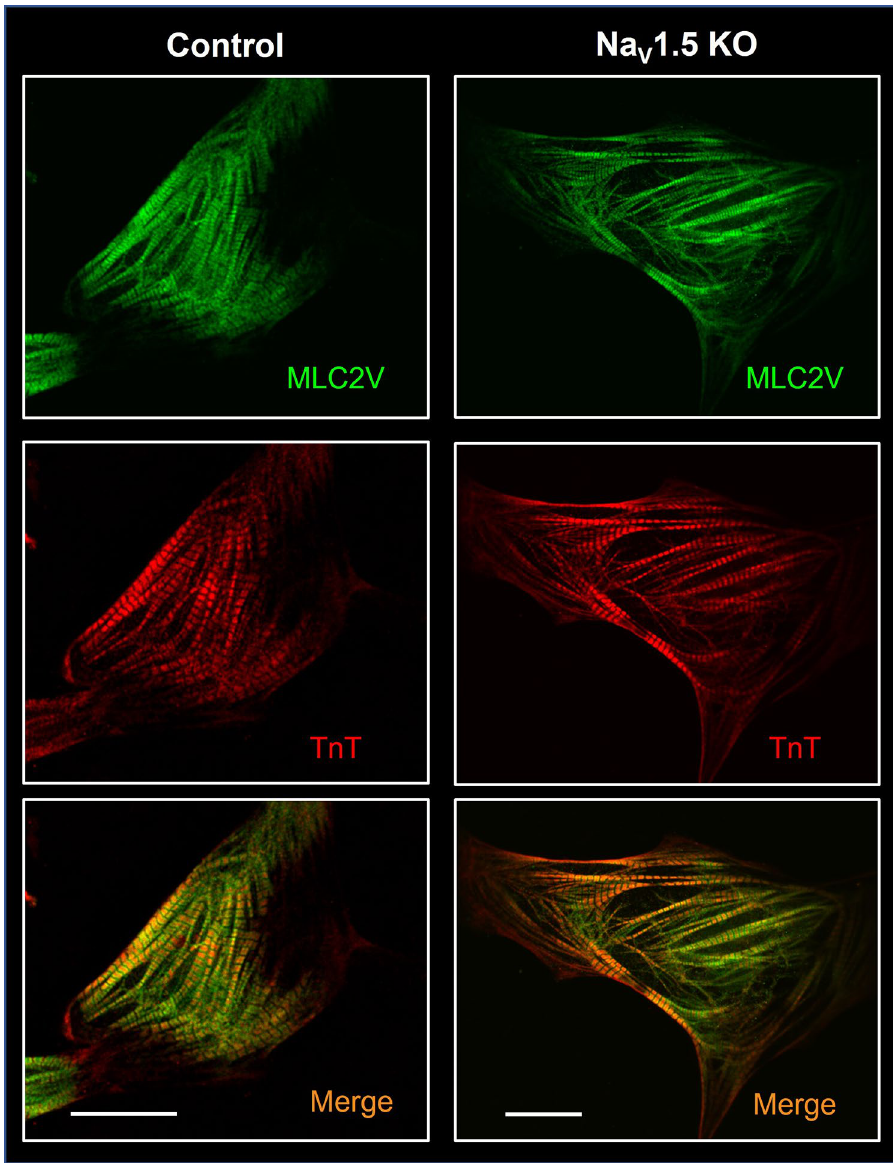
Figure 2. Immunofluorescence staining of cardiac markers in Na V 1.5 KO iPSC-CMs. NaV1.5 KO iPSC-CMs with organized contractile proteins, including myosin light chain 2v (MLC2v, green staining) and cardiac troponin T (cTnT, red staining). The bottom panels show merged images. Scale bar: 20 µm. Images were acquired using a Zeiss ImagesM2 LSM confocal microscope and were processed using ZEN software (Zeiss). This figure was made using IMAGEJ 1.52i (Java 1.8.0_66, http:// imagej. nih. gov/